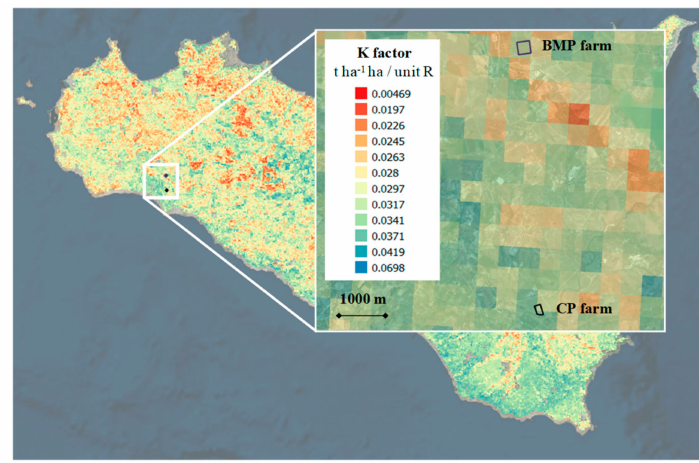
Figure 3. Spatial variability of soil erodibility K factor over the study area [22].